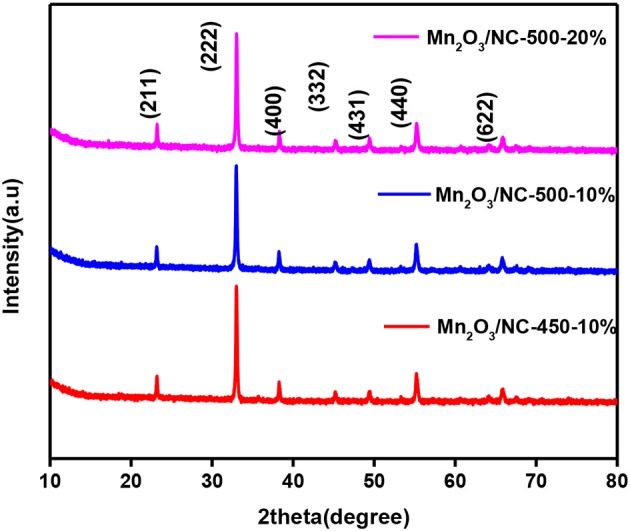
XRD patterns of Mn2O3/NC500-20%, Mn2O3/NC-500-10%, and Mn2O3/NC-450-10%.